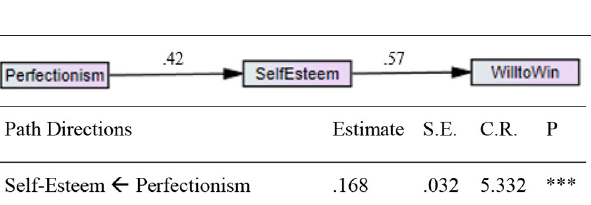
FIGURE 2 | Path analysis of the latent construct using data obtained from male athletes.